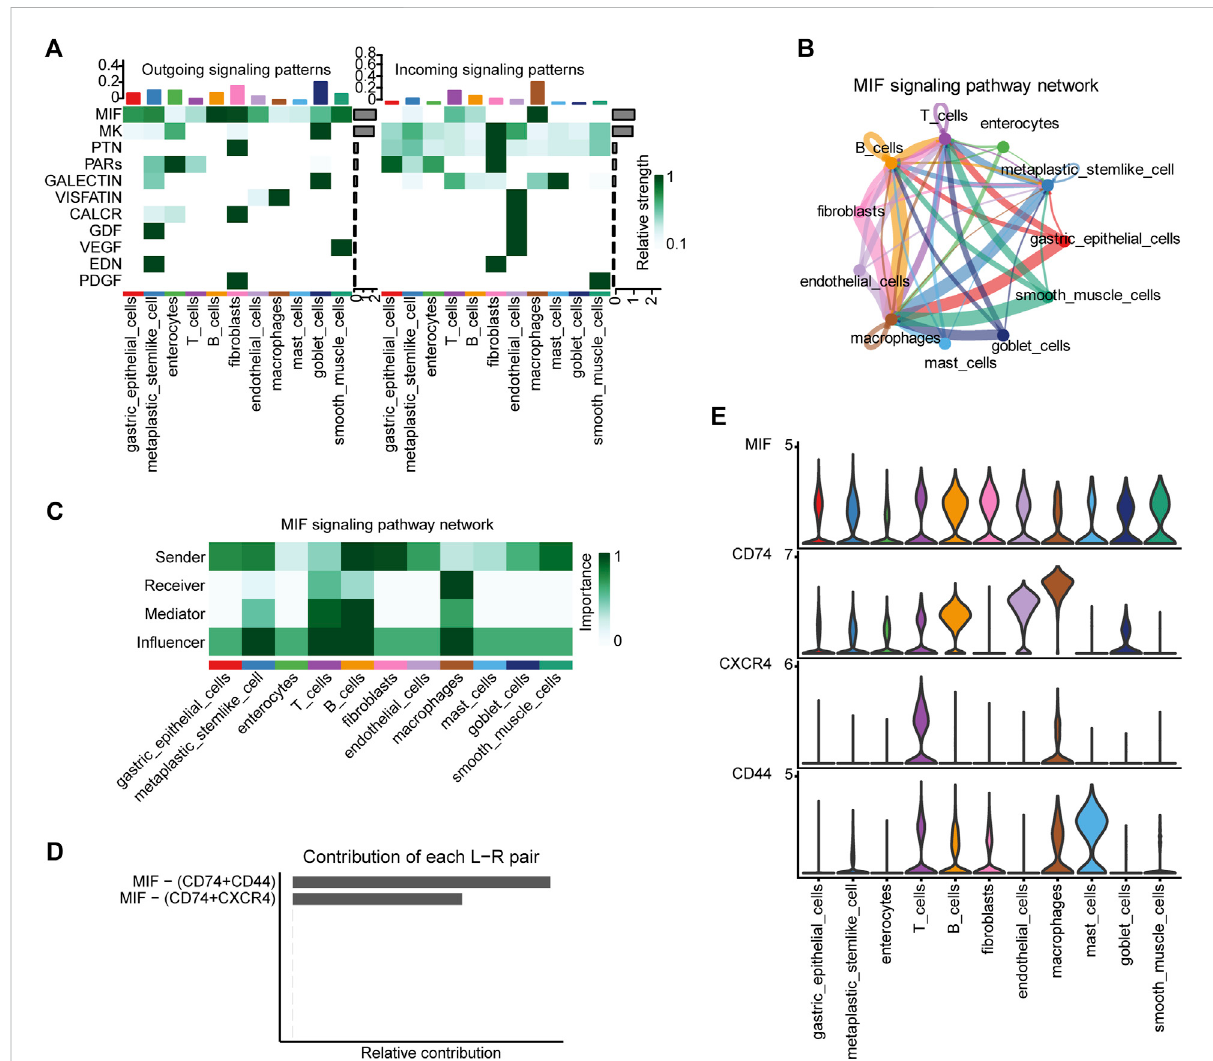
FIGURE 2 CellChat analyses of the intercellular communication network for the different cell types. (A) Contribution of the 11 pathways identi fi ed to the outgoing (left) and incoming (right) signals among the different cell types. (B) Intensity of cell – cell interactions in the MIF signaling pathway. (C) Network centrality scores of the MIF signaling pathway for each cell type. (D) Relative contribution of each ligand – receptor pair included in the MIF signaling pathway and (E) their expression patterns in the different cell